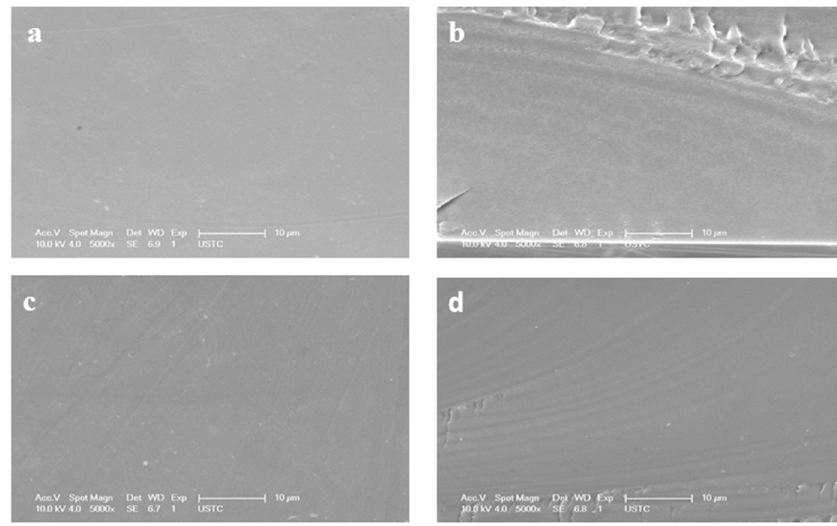
Figure 4. MDPP-36 membrane ( a ) surface area diagram ( b ) cross-section. MDP-43 membrane ( c ) surface area diagram ( d ) cross-section.